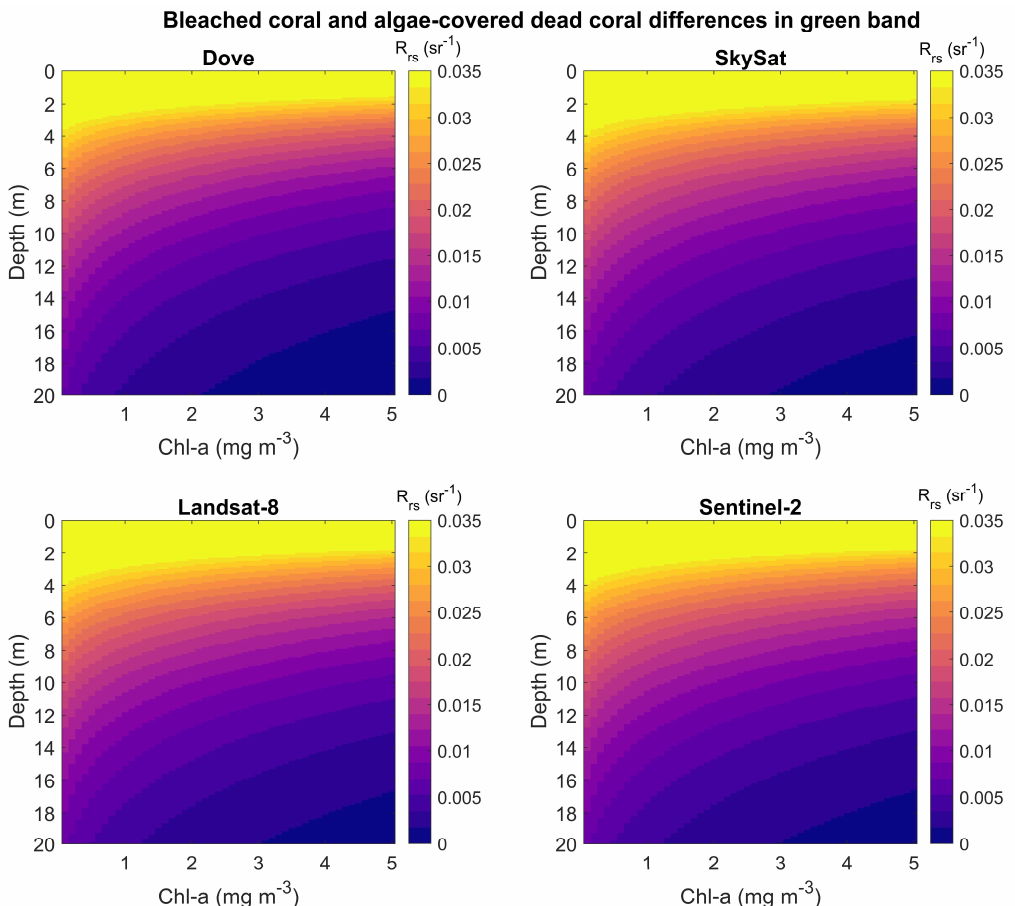
Figure 8. Differences in remote sensing reflectance between the bleached coral and algae-covered dead coral in four different satellite sensors’ green bands.